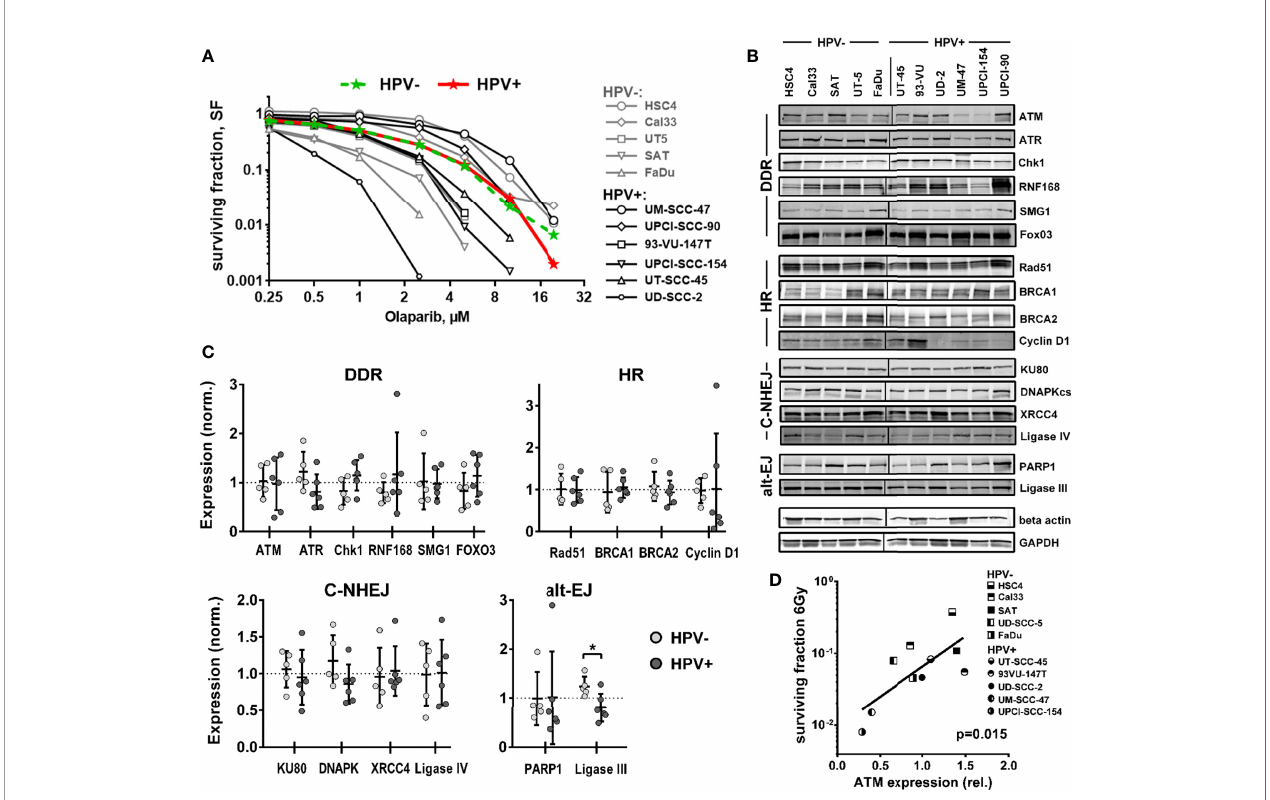
FIGURE 1 | Sensitivity towards PARP inhibition and expression of DNA repair factors. (A) Exponentially growing cells were seeded at low, de fi ned numbers and, on the next day, treated with olaparib as indicated. After one week, the medium was exchanged and the cells were incubated without the inhibitor until the formation of colonies. Colored curves represent group means. (B) Expression of DNA repair factors in HPV+ and HPV − HNSCC cell lines as determined by Western blot analysis from exponentially growing cells. Note that TRIP12 expression was also tested but no interpretable results were obtained. (C) Quanti fi cation and comparison of DNA repair factors by HPV status. Individual expression is depicted as normalized to the average expression of the whole cohort (dotted line). An asterisk indicates signi fi cance (p <0.05, two-tailed Student ’ s t-test). (D) Association of ATM expression and cell survival in 5 HPV+ and 5 HPV − HNSCC cell lines at 6 Gy as reported previously by us